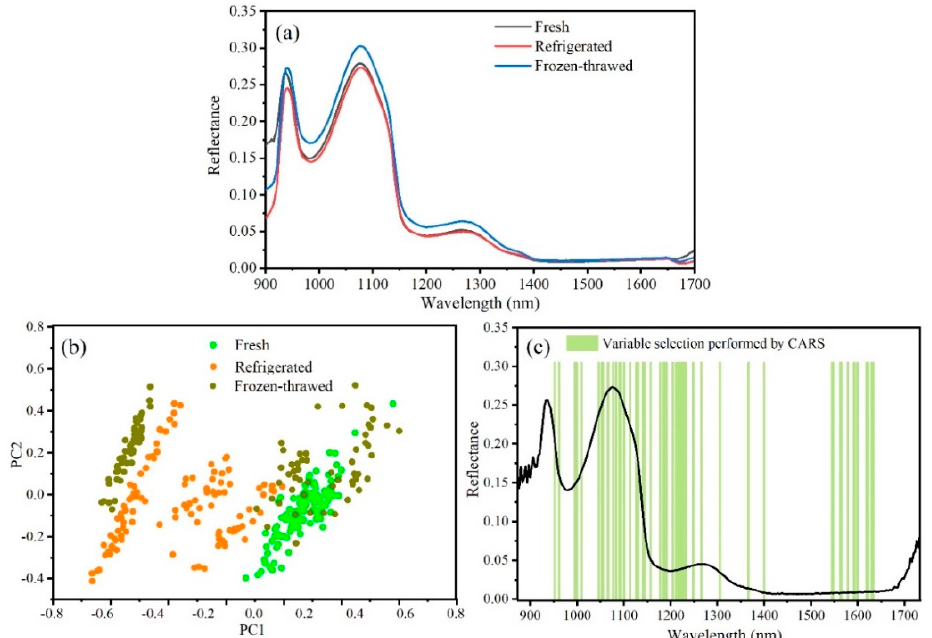
Figure 3. Classification model for fresh, refrigerated, and frozen–thawed fish: ( a ) Average spectra of fresh, refrigerated, and frozen–thawed fish; ( b ) classification results performed by principal component analysis (PCA) model; ( c ) variable selection performed by competitive adaptive reweighted sampling (CARS).